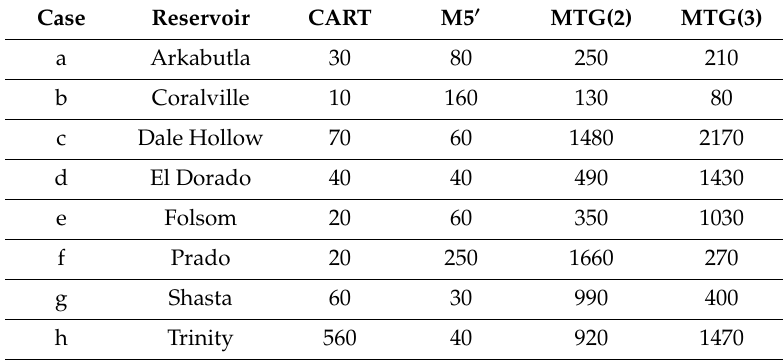
Table 5. The minimum leaf size value for each case study and algorithm.